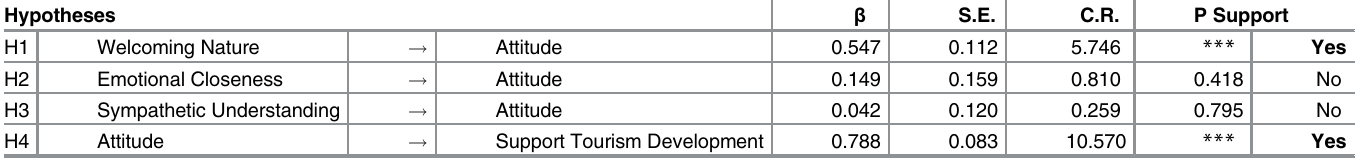
Table 2. Hypothesis testing on residents support for tourism development.